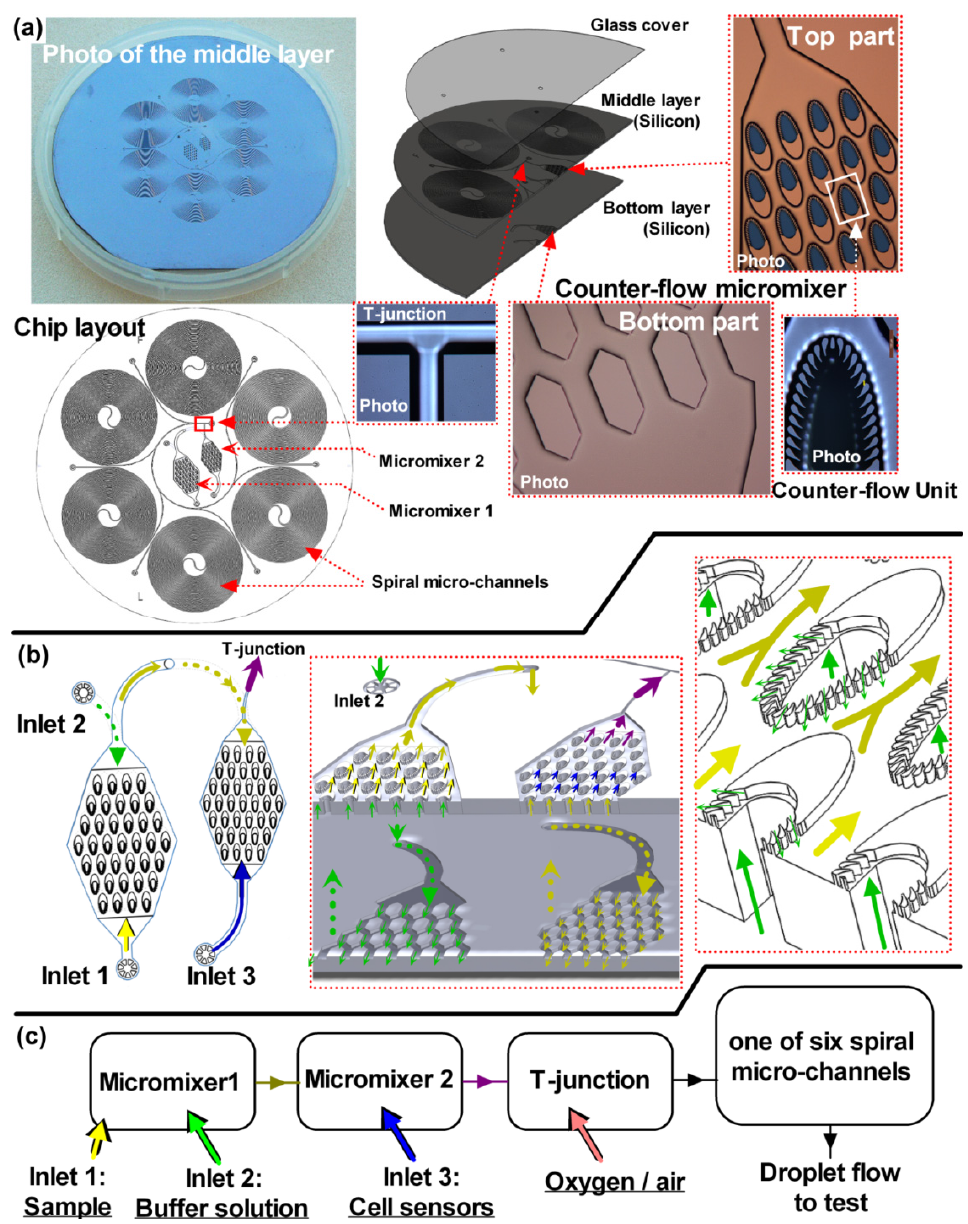
Figure 1. Construction of the cell-based LOC device. ( a ) The chip has three layers, but the three major structures are in the middle layer, including two counter-flow micromixers, a T-junction droplet generator and six spiral micro-channels. A photo of the device is shown in the top left corner. The schematic and micrographs of the counter-flow micromixer are illustrated at the top right part, which houses the counter-flow units (on the middle layer) and the inlet channels (on the bottom layer). The tiny inlet port is located in the center of the counter-flow unit. ( b ) Two counter-flow micromixers are connected in series. The solution flowing in the bottom layer penetrates through the tiny inlet ports in the counter-flow units and then mixes with another solution near the pillar gaps around the tiny inlet port. ( c ) The map of the chip domains is shown at the bottom. The sample, buffer solution and the cell suspension are mixed and used to form droplet within the air